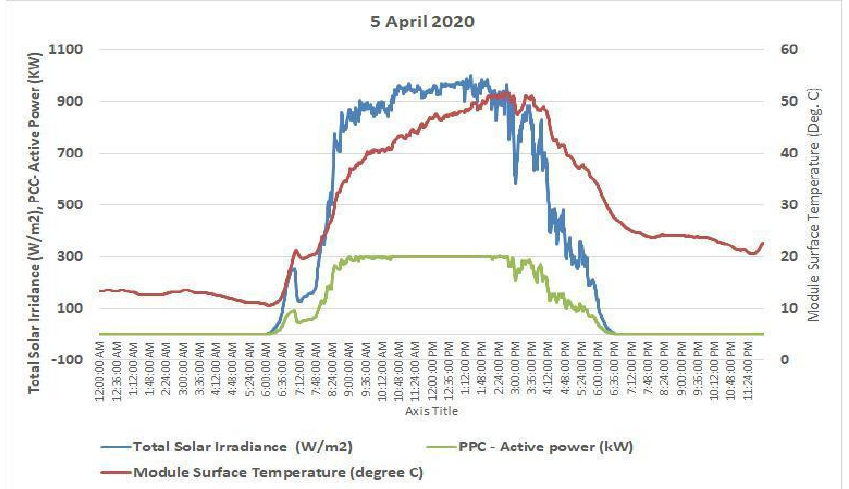
Figure 16. Variation of active power with temperature and irradiance on a day with moderate temperature.